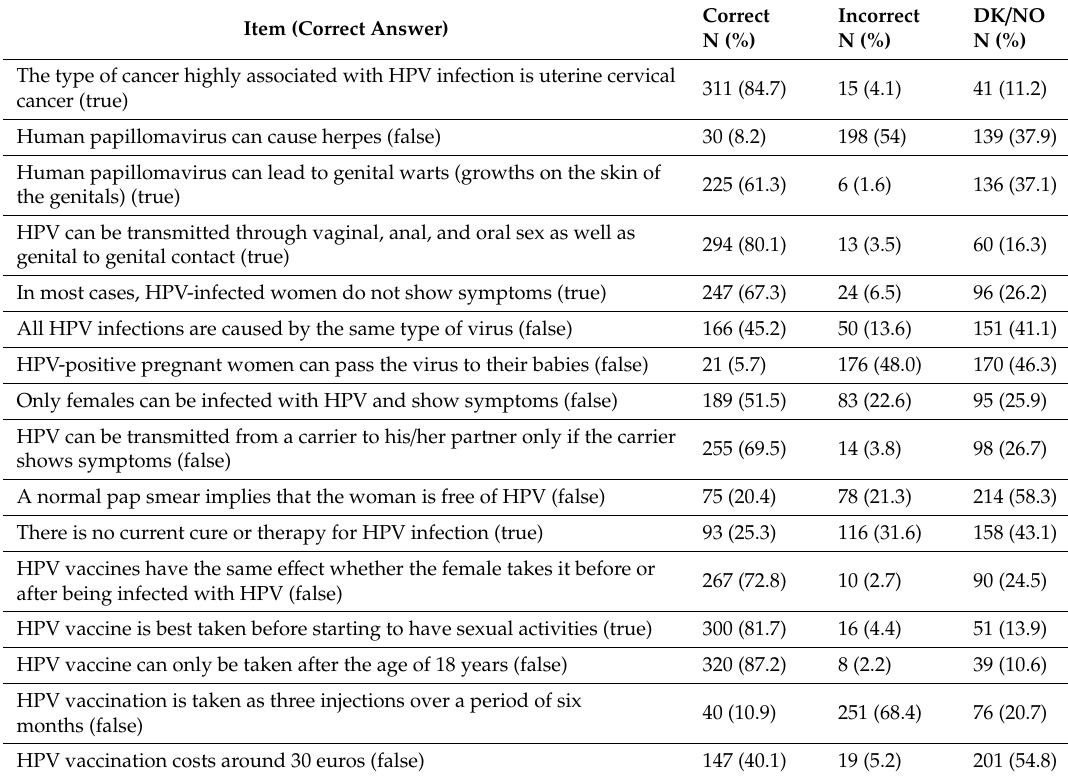
Table 2. Knowledge of HPV infection and